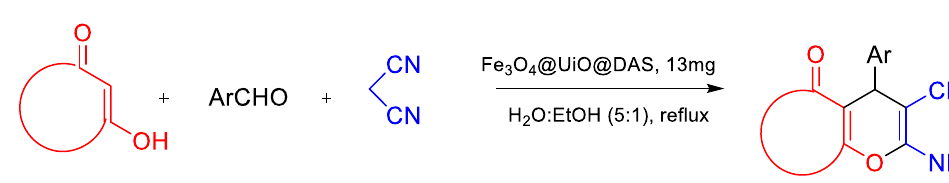
Figure 3. Synthesis of 4 H -Chromene derivatives catalyzed by Fe 3 O 4